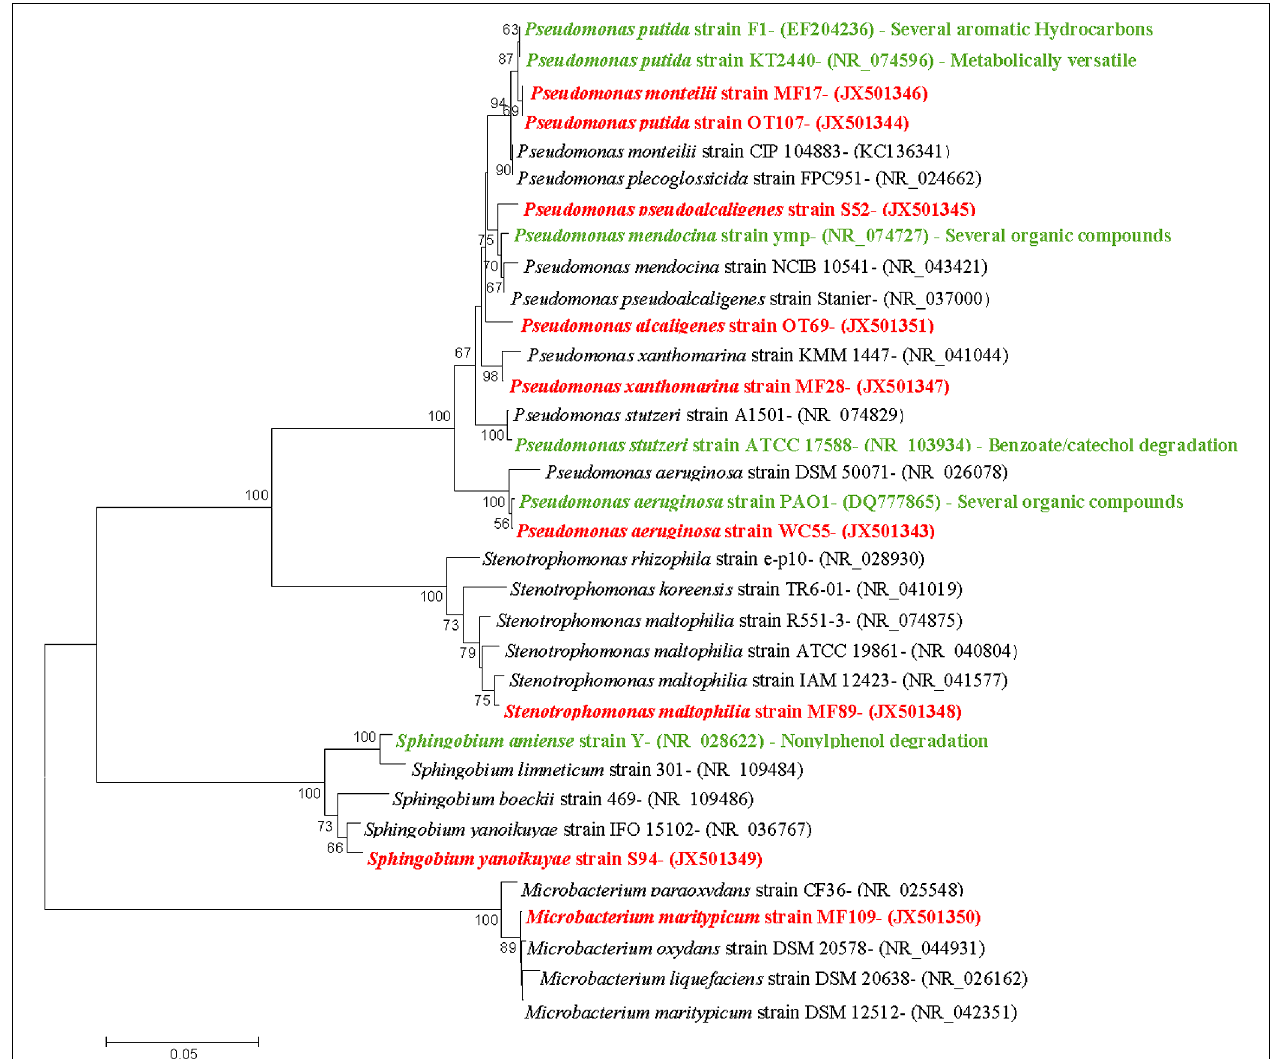
number of base substitutions per site.The analysis involved 34 nucleotide sequences and positions containing gaps and missing data were eliminated. There were a total of 664 positions in the final dataset.The nine isolates obtained from oyster and its surrounding environments in this study are shown in red text; previously known biodegradative relatives are shown in green